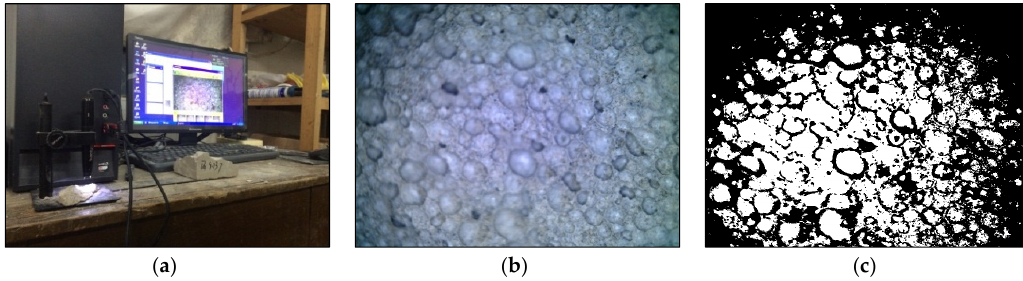
Figure 1. Image processing of porosity, ( a ) image acquisition, ( b ) original image of porosity, ( c ) grayscale porosity.